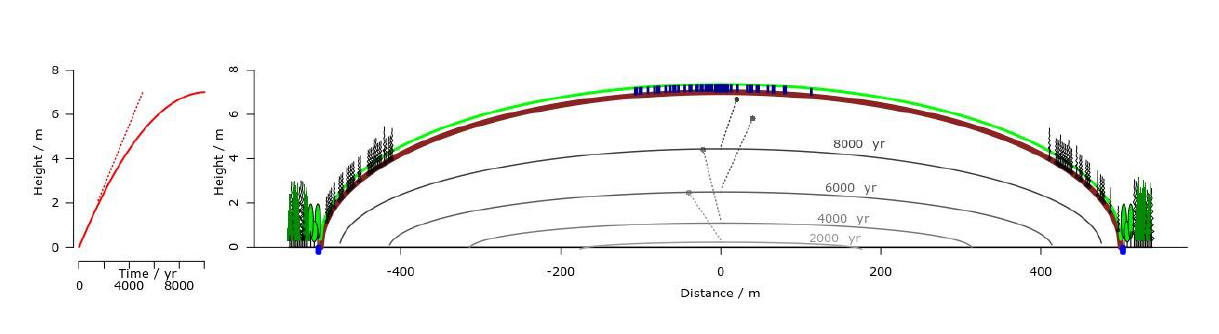
Figure 1. Final frame of the Simulation 1 video representing the state after 10,000 yr of growth of a raised bog starting from the centre of a plain, with constant decay (see text). Green represents the living surface (roughly the acrotelm). Brown is the top of the peat proper (roughly the top of the catotelm, the rest of which below is white). Grey are the ghosts of former surfaces at 2000 (lowest), 4000, 6000, and 8000 (highest) yr after the start; each ghost is linked to its original position (small circle) by a dashed line. Blue are pools. The peripheral fringe inside the perimeter of trees on the bog surface may be considered to be pine or larch. Surrounding the peat mass are a lagg fen with deciduous trees, and a spruce/pine forest (forest trees schematic, and only 1/5 the height they would be if to scale). The graph at the left shows the growth in height with time (thicker line) and what it would have been without decay (thinner straight dashed